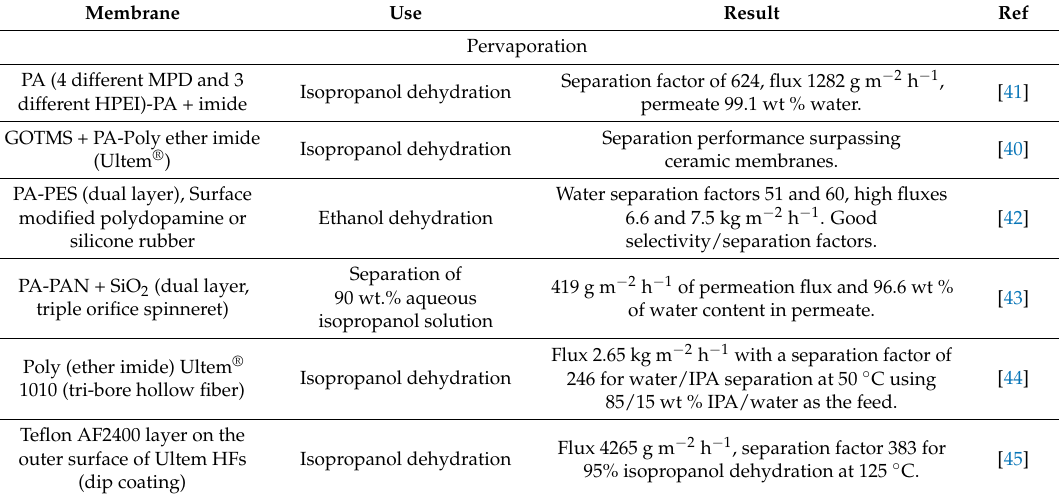
Table 2. TFC hollow fiber membrane for separation and dehydration of alcohols via pervaporation. Membrane Use